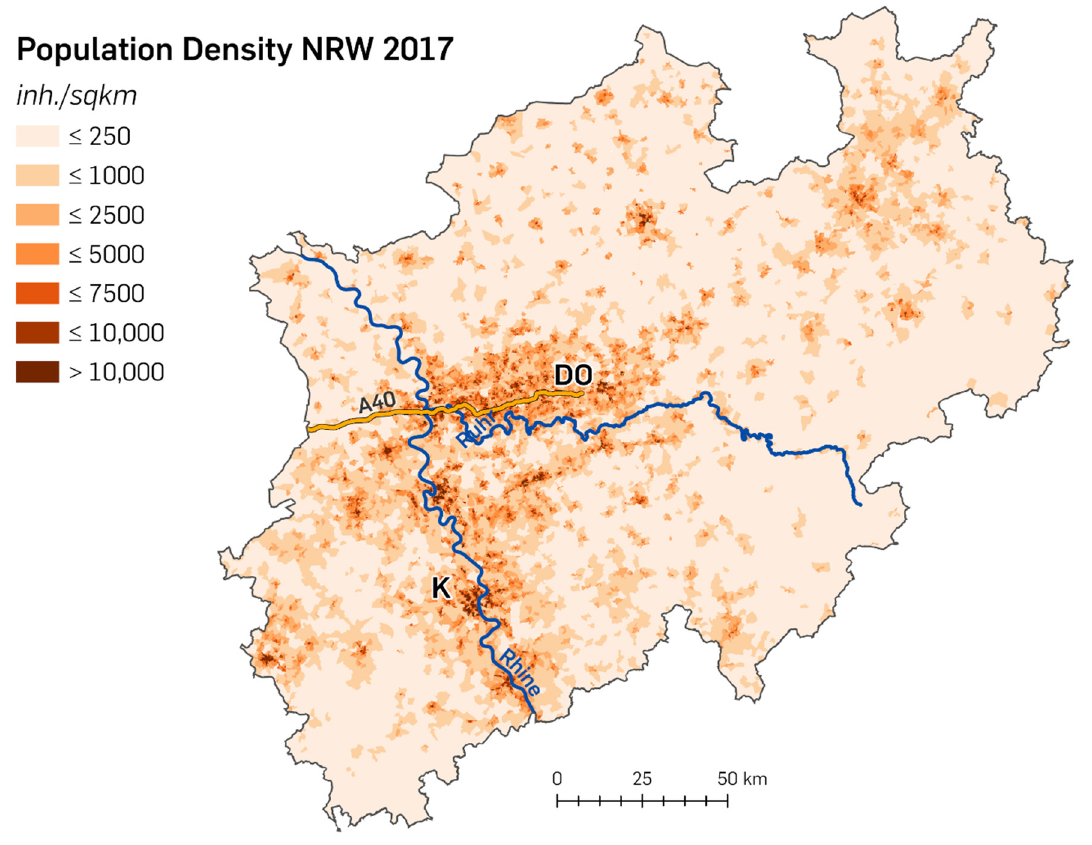
Figure 2. Population density 2017 of North Rhine-Westphalia based on PLZ8 polygons, K: Cologne, DO: Dortmund (Data source: [23,25,26]).